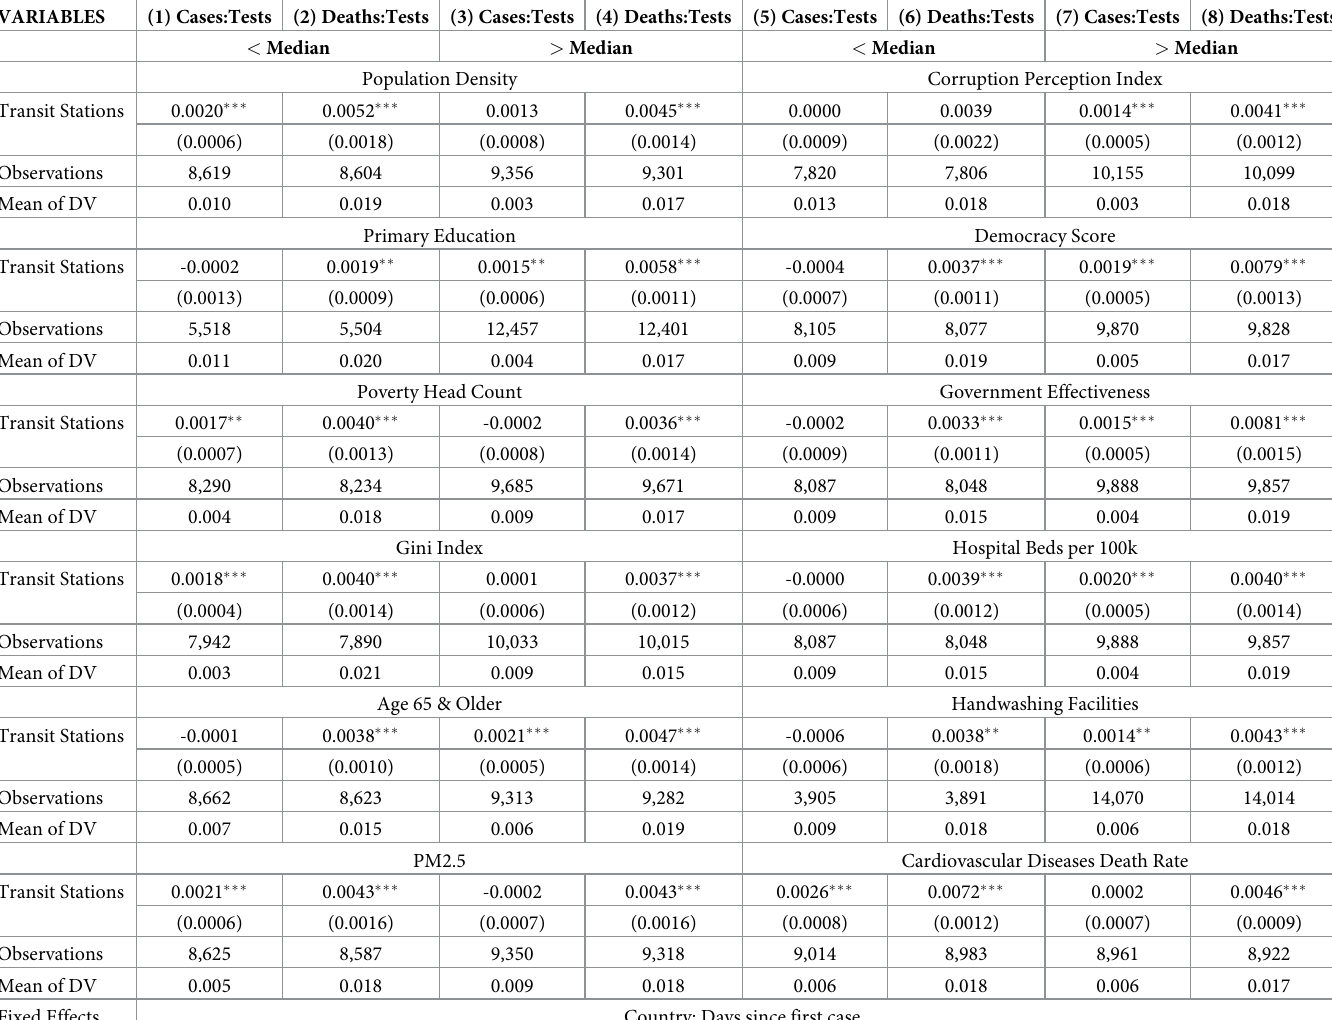
Table 8. Heterogenous impact of transit station mobility on growth rates: Recursive mixed-process model. VARIABLES